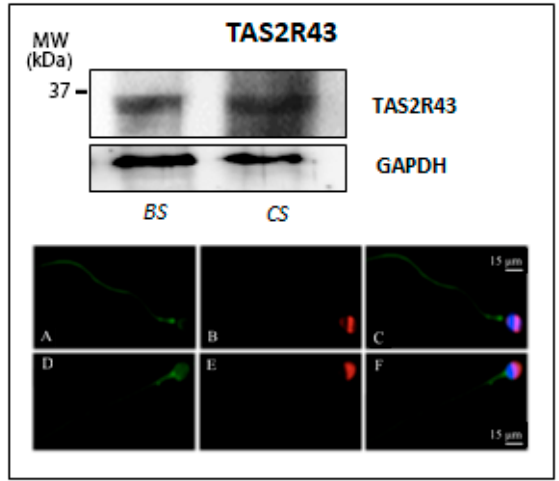
Figure 4. Expression of TAS2R43 in human ejaculated sperm. ( Top ) Western blot of TAS2R43 in ejaculated sperm before (BS) and after in vitro capacitation (CS). GAPDH was immunodetected to control equal loading per lane of each sperm preparation. ( Bottom ) Representative micrographs (from three independent experiments) of immunofluorescence staining of TAS2R43 (green), PSA (red), and DAPI (blue) in ejaculated sperm in uncapacitated sperm ( A – C ) and after in vitro capacitation of male gametes ( D – F ). Scale bar = 15 µ m.